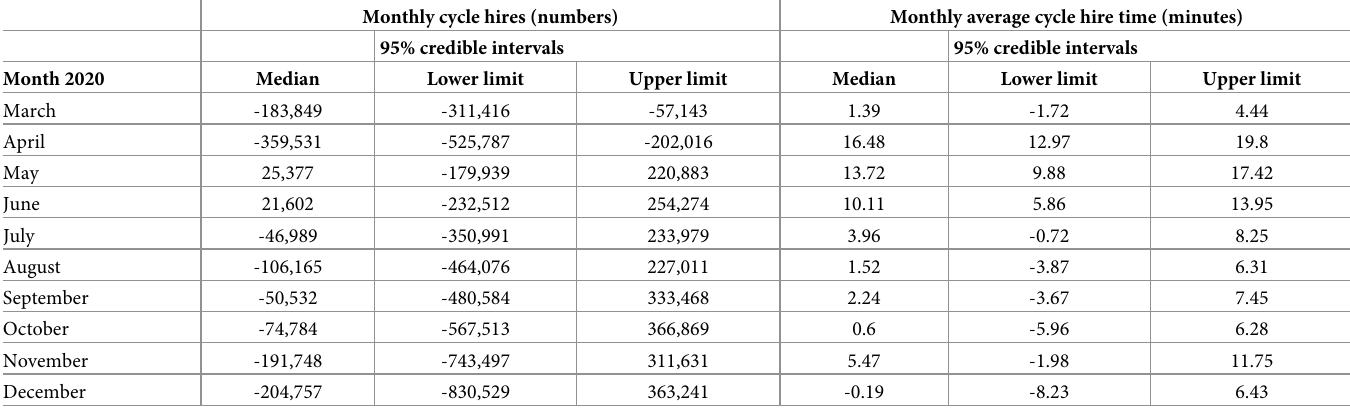
Table 4. Estimated change in the London bike-sharing